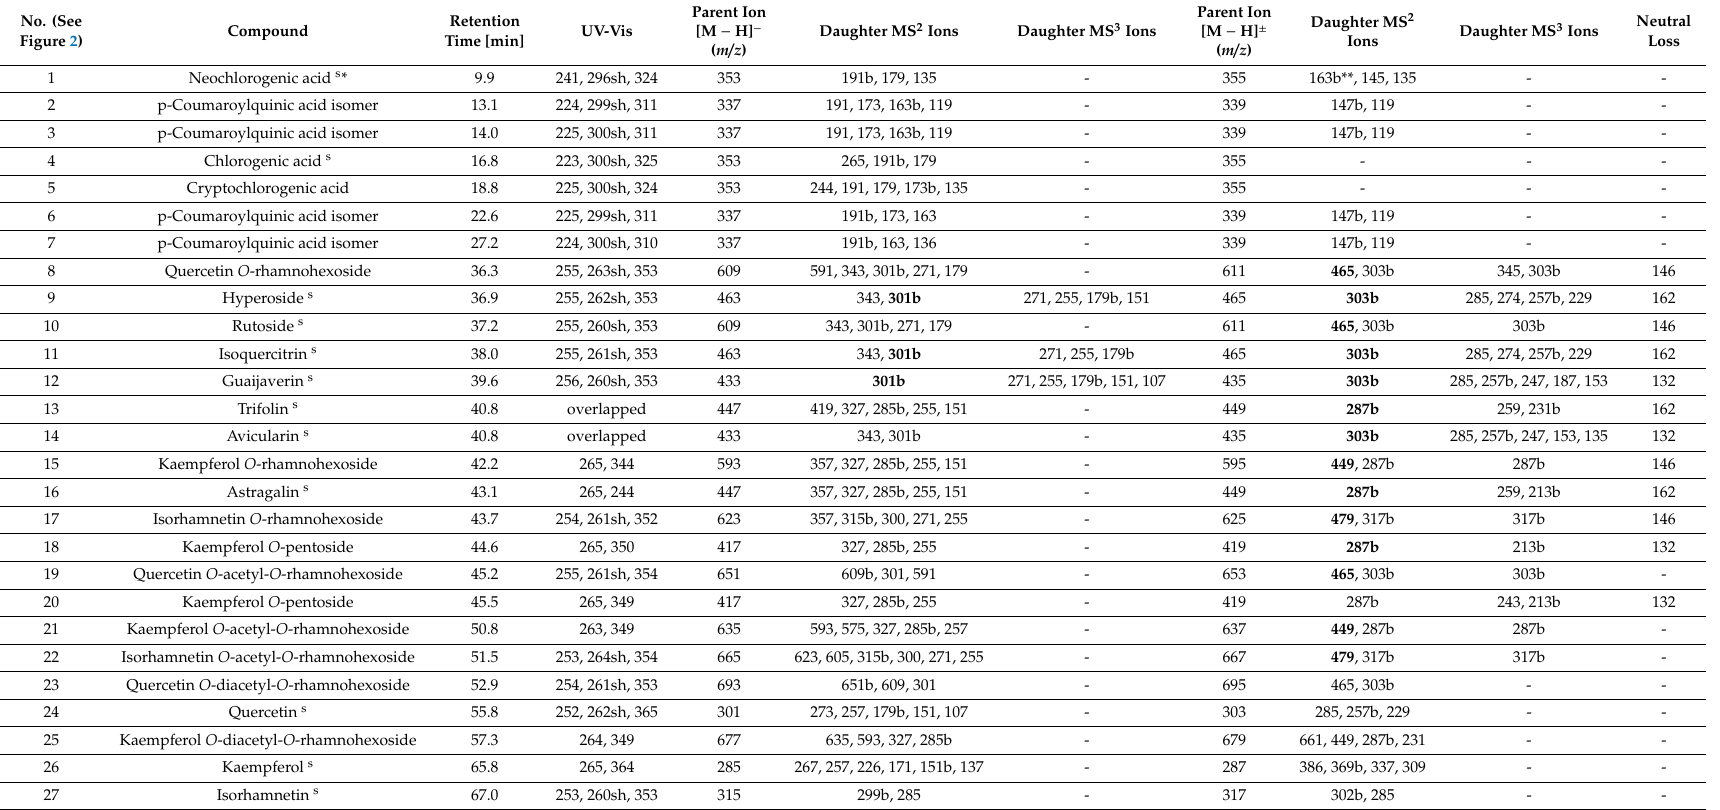
Table 1. The phenolic profile of S. rubriflora extracts determined by UHPLC-DAD-ESI-MS 3